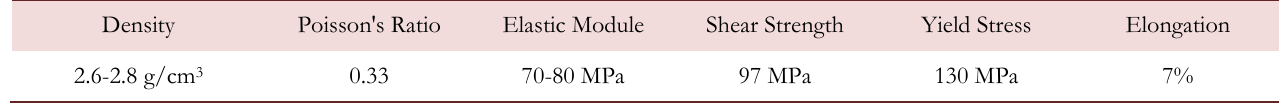
Table 5: The mechanical properties of aluminum alloy AA3105 [33].